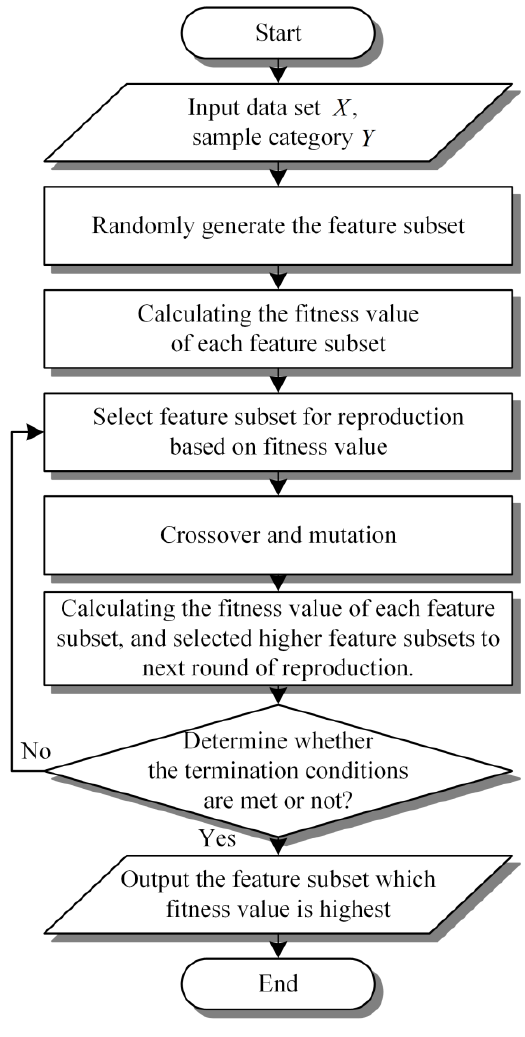
Figure 5. The flow chart of GA.